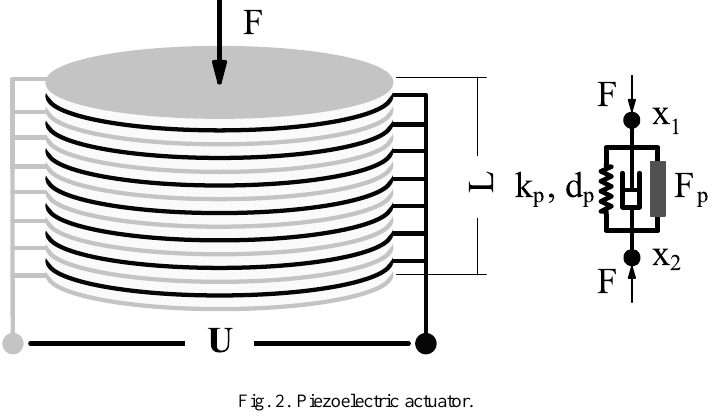
Fig. 2. Piezoelectric